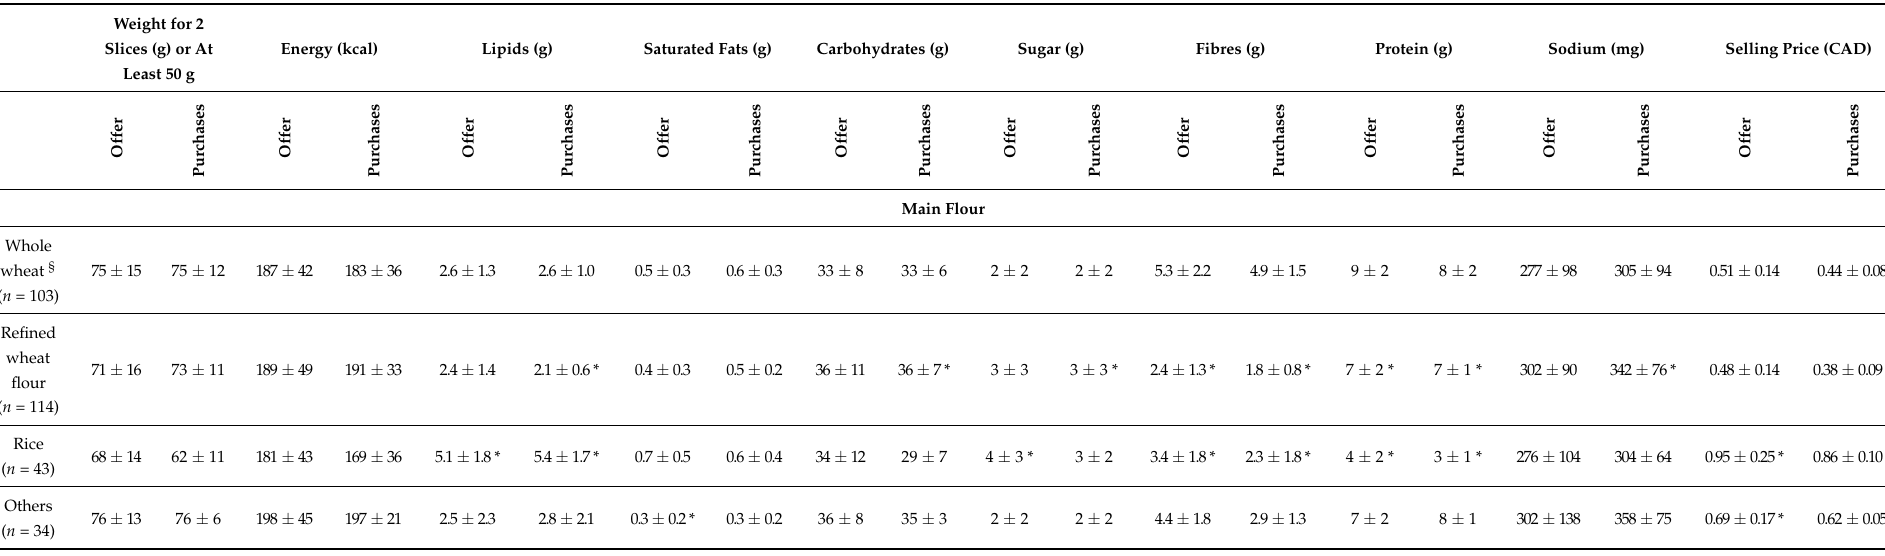
Table 3. Nutritional value and selling price per two-slice portion of sliced bread offered and purchased in Quebec, according to the main flour.